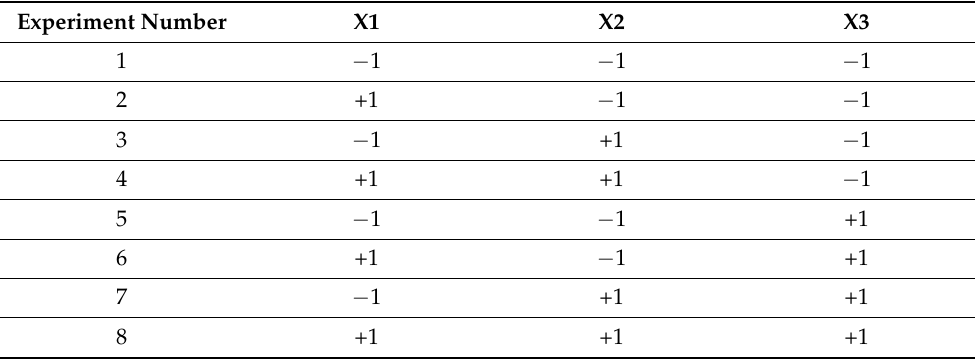
Table 2. The design matrix of the full factorial experiment. Experiment